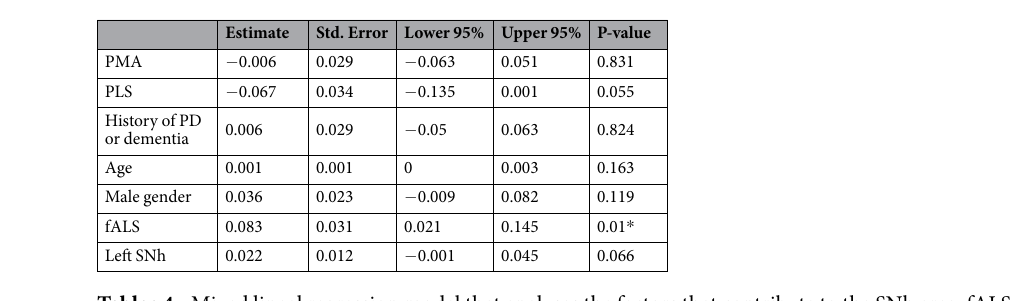
Tablee 4. Mixed lineal regression model that analyses the factors that contribute to the SNh area. fALS: familial ALS; PLS: primary lateral sclerosis; PMA: progressive muscular atrophy; PD: Parkinson’s disease; SNh: hyperechogenicity of substantia